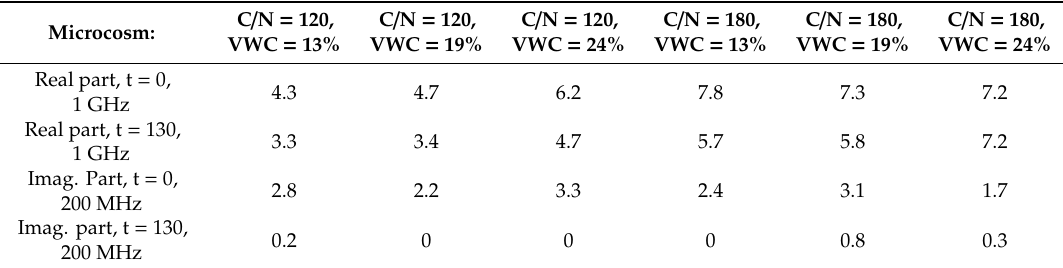
Figure 10. Complex dielectric permittivity before bioremediation and after 130 days: real part ( a ), imaginary part ( b ). Microcosm: C/N = 180. Volumetric water content = 24%. Table 2. Summary of complex dielectric permittivity measurements on the microcosms. Due to the accuracy issues, these values must be taken only as qualitative.